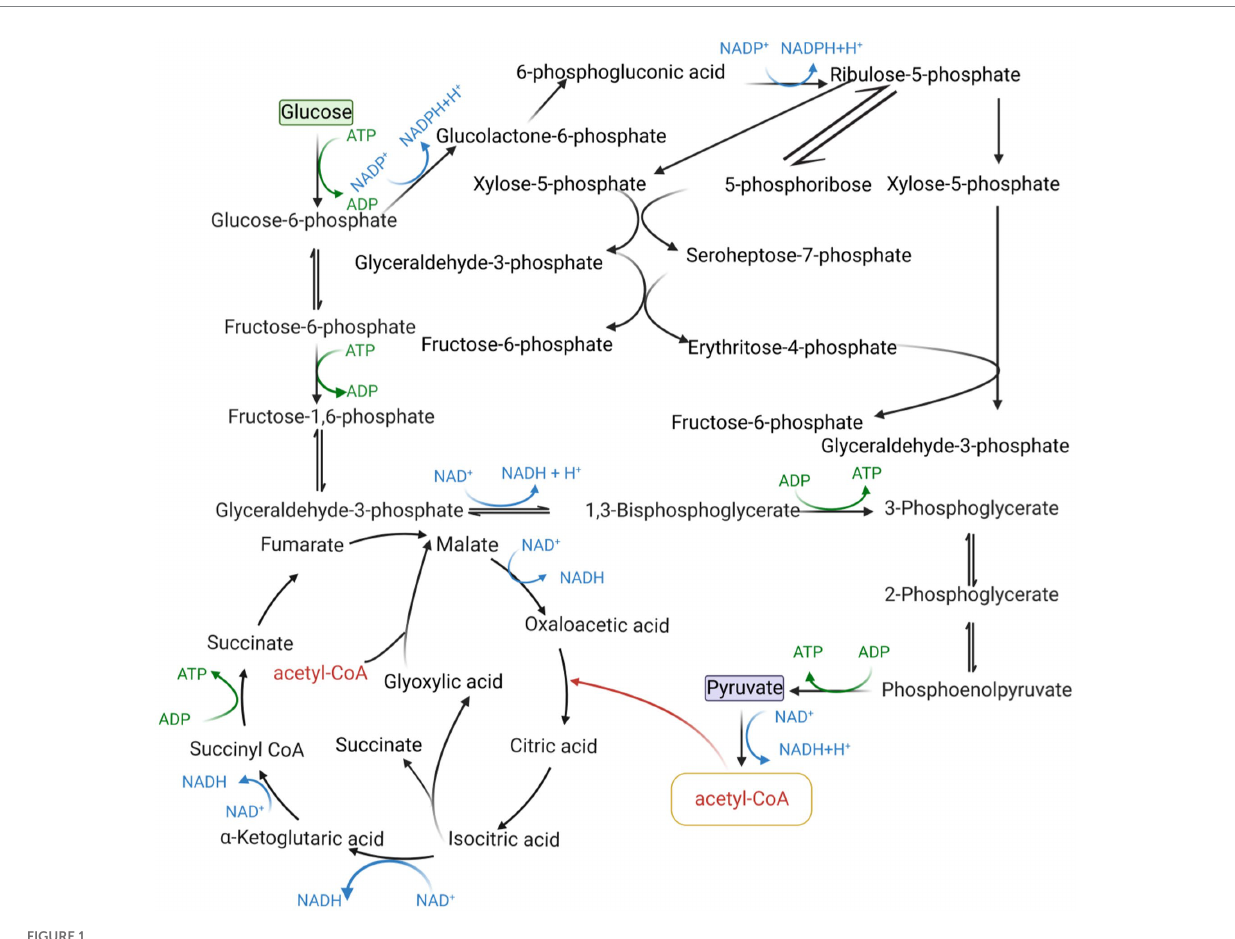
FIGURE 1 Pathway of cofactor production in microbial